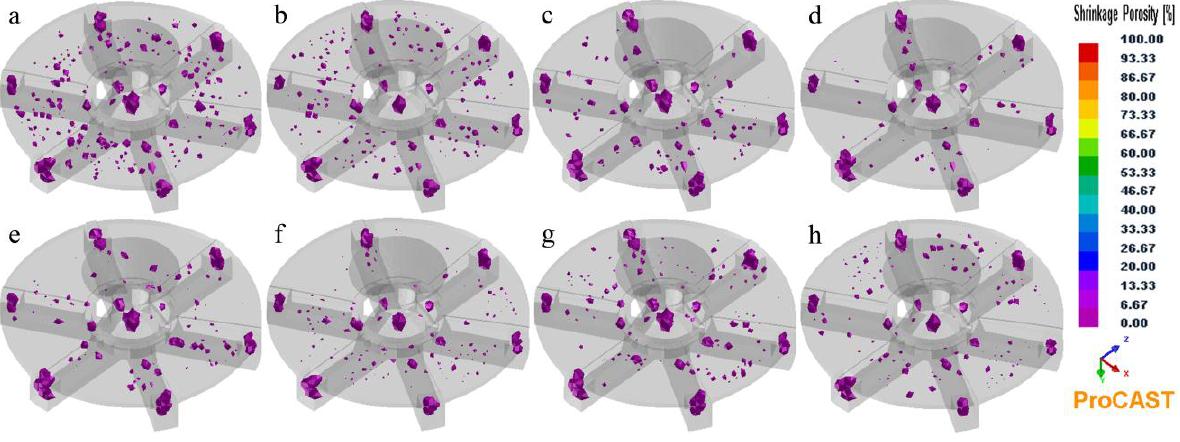
Figure 2. The predicted shrinkage porosity of test castings: ( a ) mold temperature of 25 °C and gravity casting (short for 25 °C, 0 rpm); ( b ) 800 °C, 0 rpm; ( c ) 25 °C, 200 rpm; ( d ) 800 °C, 200 rpm; ( e ) 25 °C, 400 rpm; ( f ) 800 °C, 400 rpm; ( g ) 25 °C, 600 rpm; ( h ) 800 °C, 600